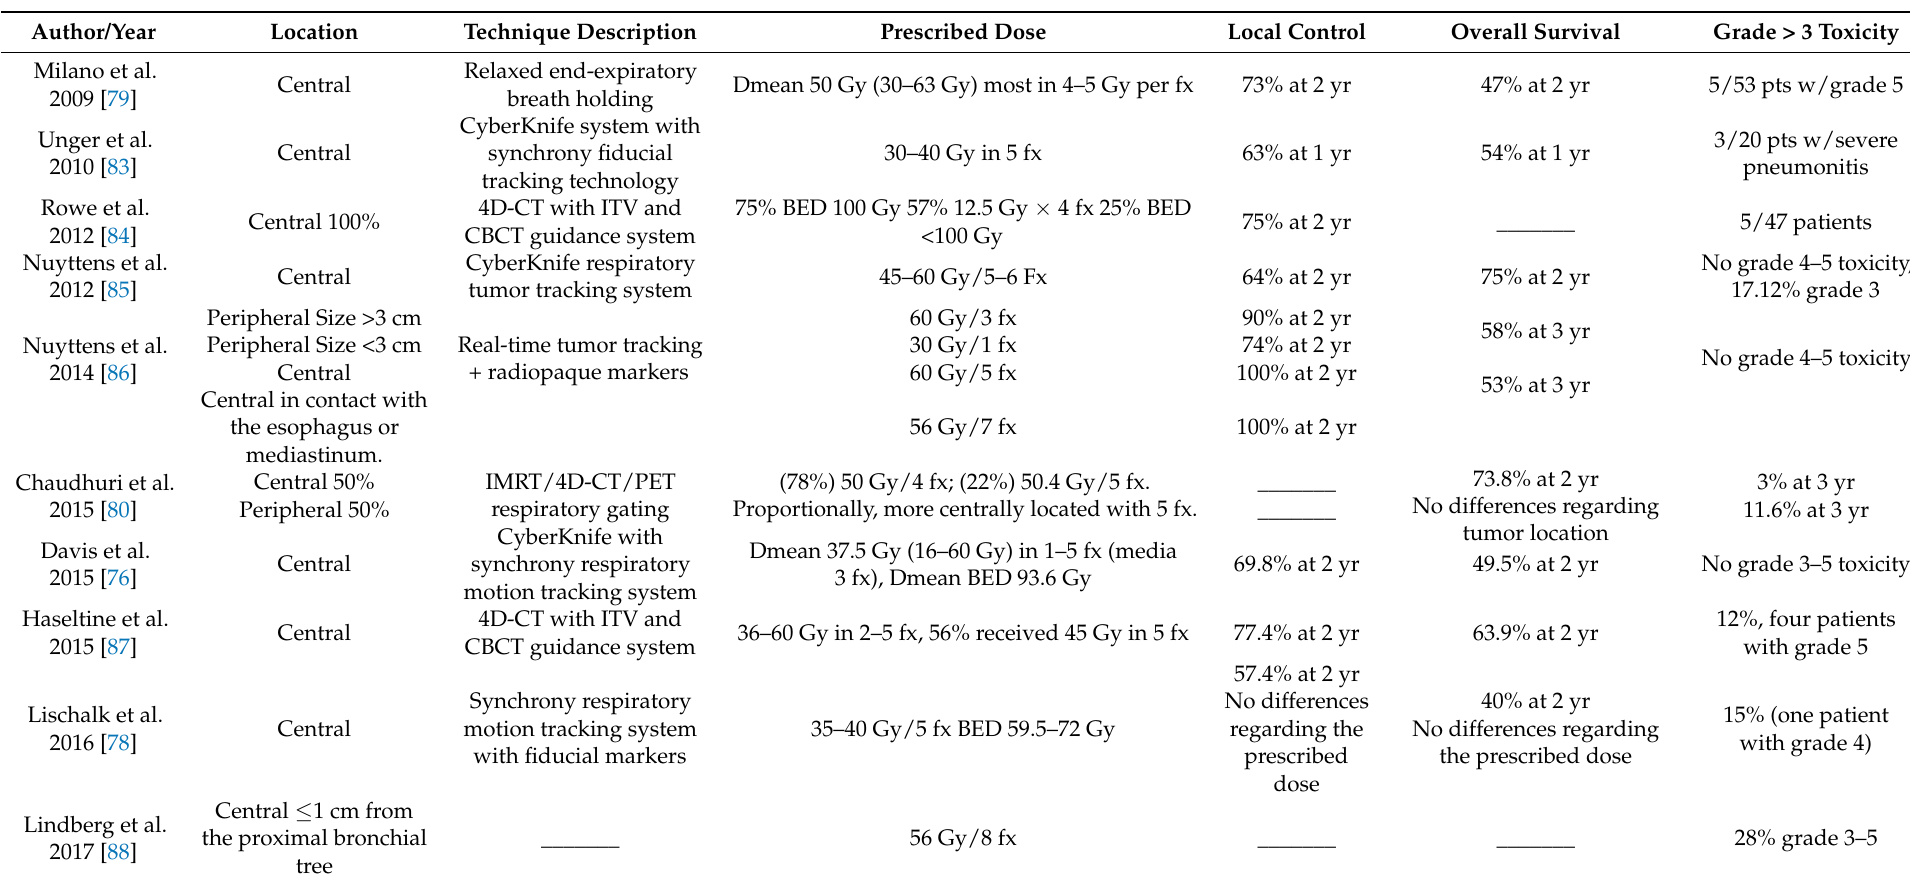
Table 2. Brief Summary of published studies of lung SBRT-treated central and central/peripheral lung metastases and differences in the prescribed